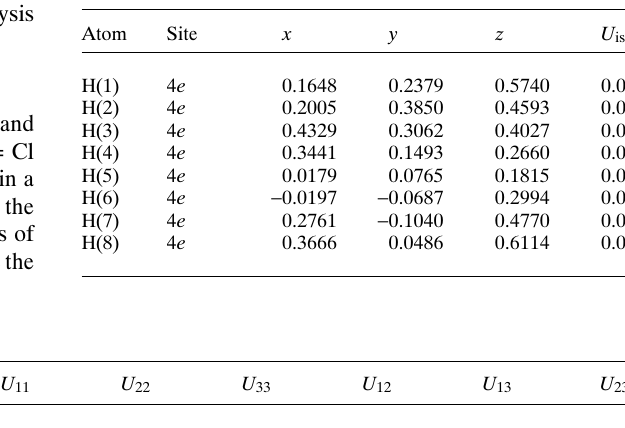
Table 2. Atomic coordinates and displacement parameters (in Å 2 ) .